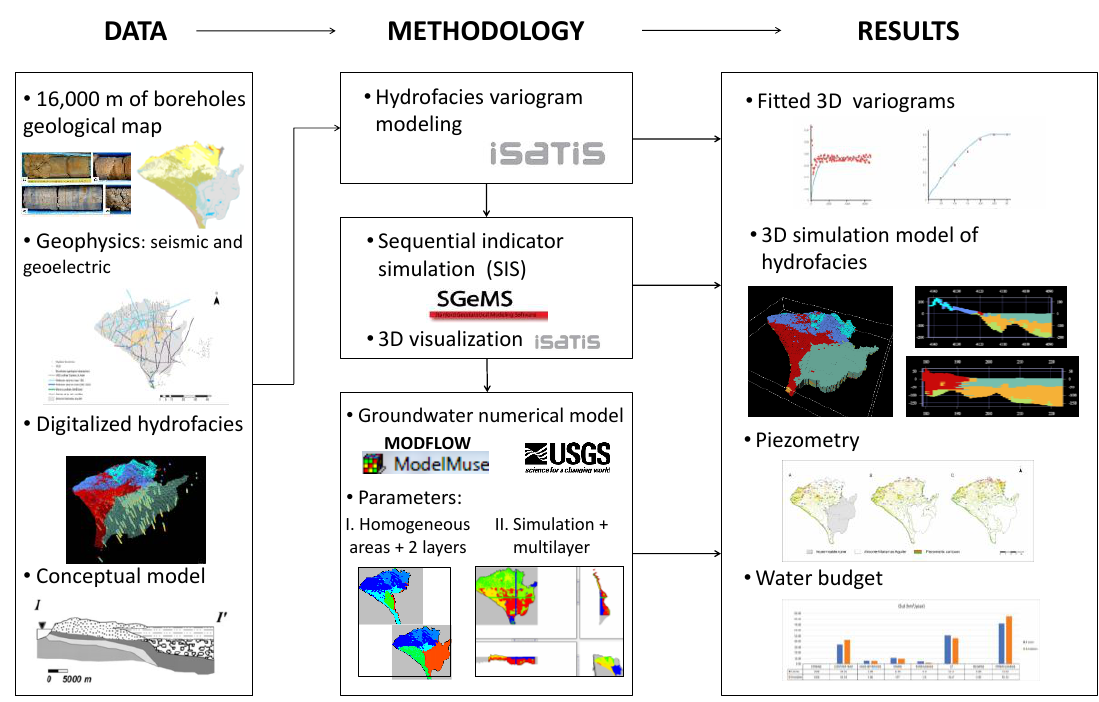
Figure 4. Flowchart of the approach used in the current study.